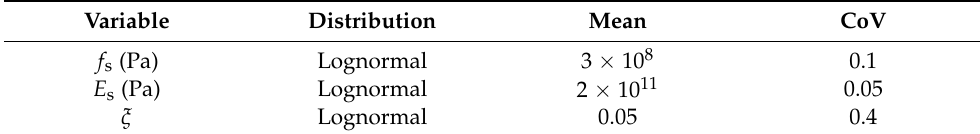
Table 2. Statistical properties of the structural parameters.